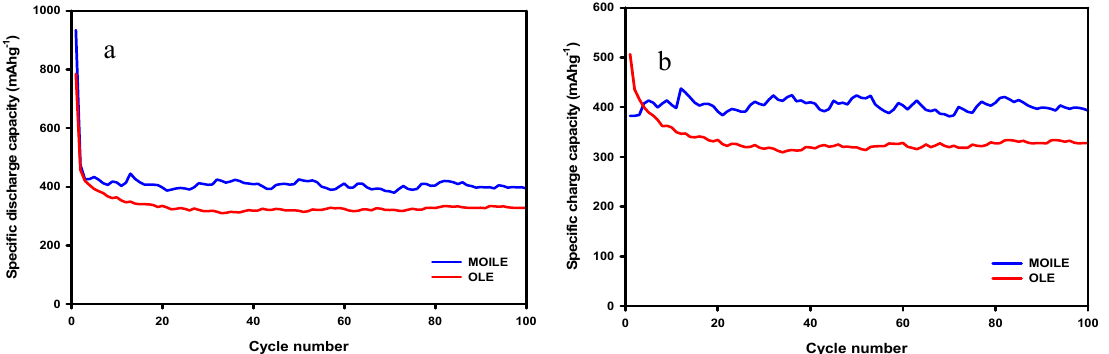
Figure 9. Cycling performance of a SnO 2 /C composite-fiber anode at 25 °C in two different electrolytes: ( a ) 1M LiPF 6 in EC/DMC (1:1 v/v) electrolyte, and ( b ) 1 M LiTFSI in 60% EMI-TFSI/ 40% EC/DMC (1:1 v/v) with 5 wt% SN.